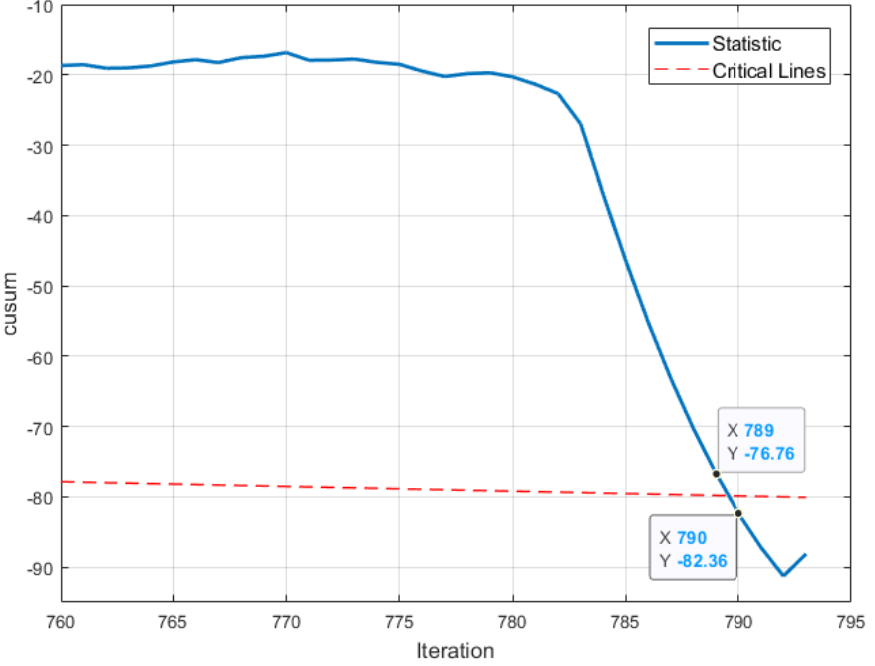
Figure 11. Zoomed data from Figure 10 displaying the detection process of F2.